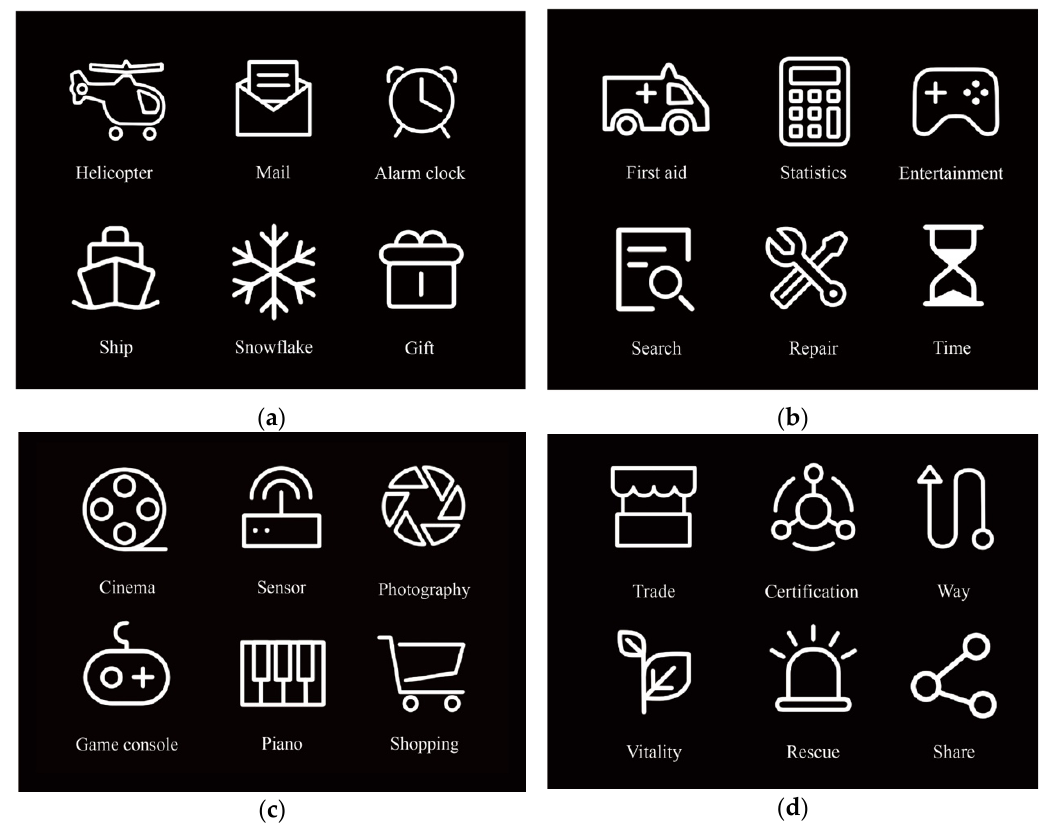
Figure 1. Examples of four groups of experimental materials. Subfigure: ( a ) concrete graphic + concrete text; ( b ) concrete graphic + abstract text; ( c ) abstract graphic + concrete text; ( d ) abstract graphic + abstract text.